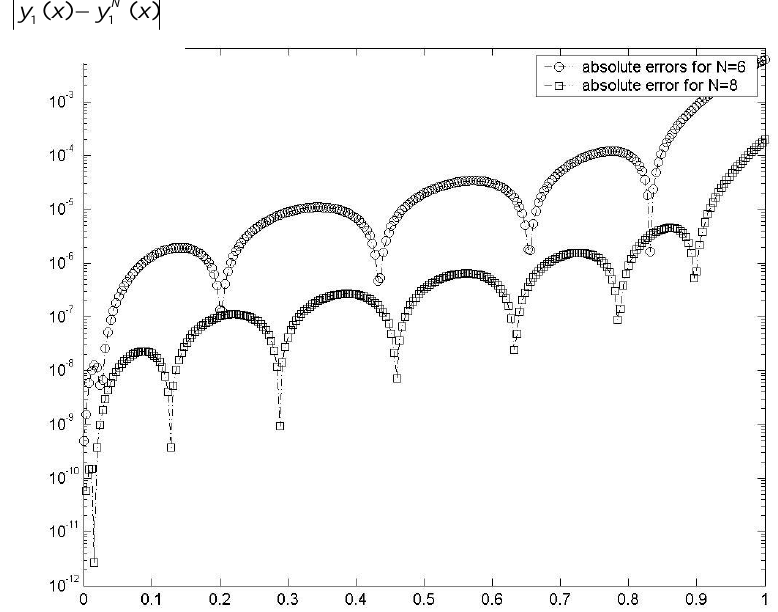
Figure 1. Comparison of absolute errors function for y 1 ( t